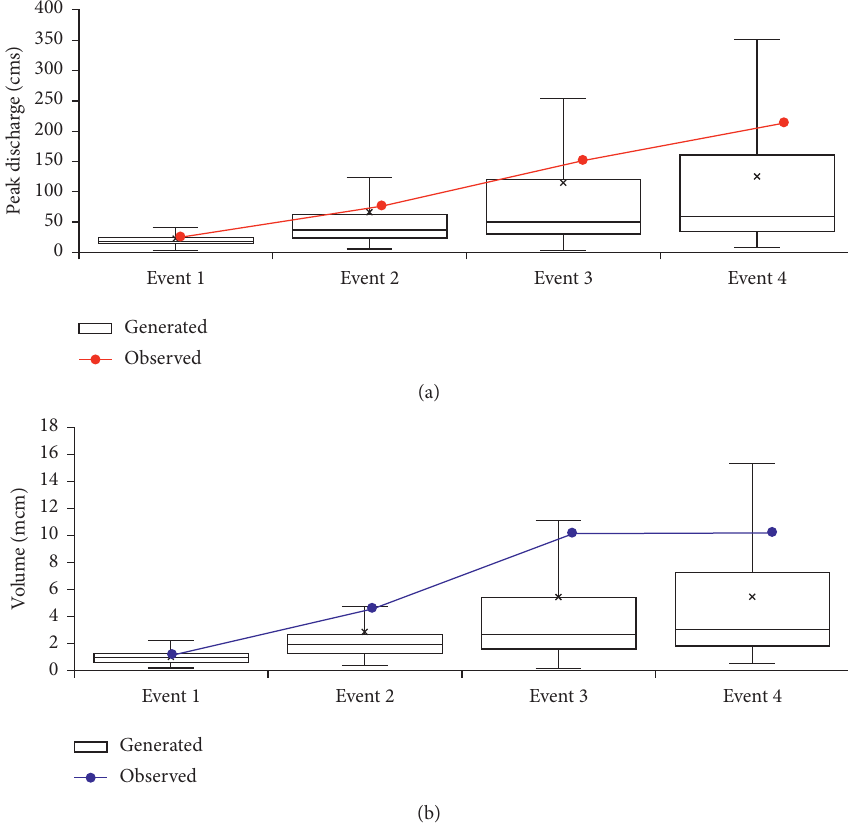
Figure 3: Comparison of observed and generated peak discharges and flood volumes.